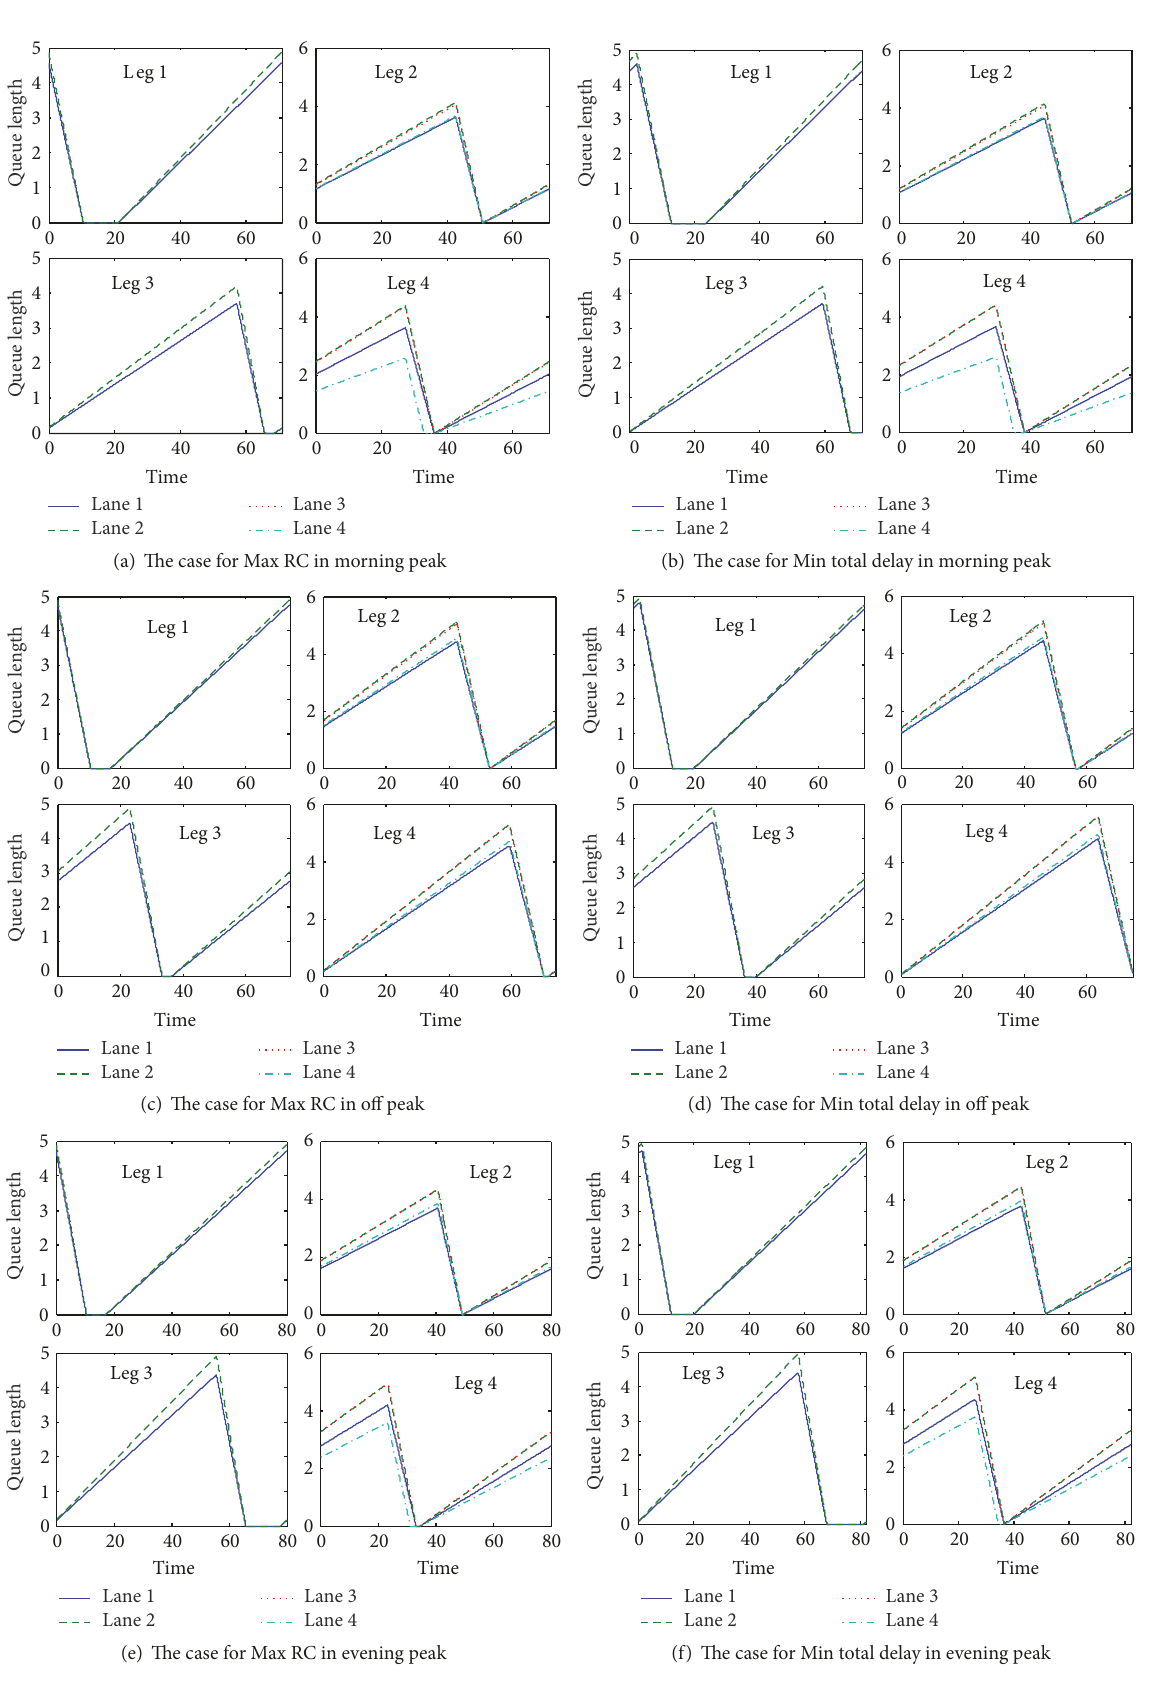
Figure 11: Queue length (in pcu) against time (from start to end of a signal cycle in seconds) under the refined traffic signal